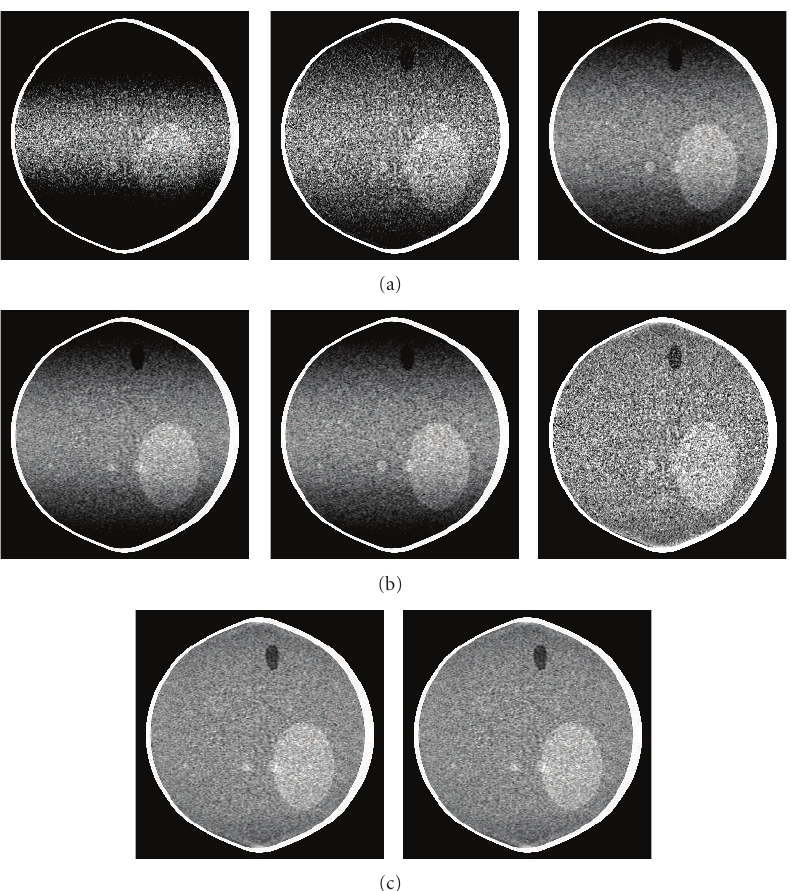
Figure 13: Slices of Shepp-Logan low contrast phantom at x = 0, reconstruction with (a) FDK algorithm, Hu’s algorithm, T-FDK algorithm,